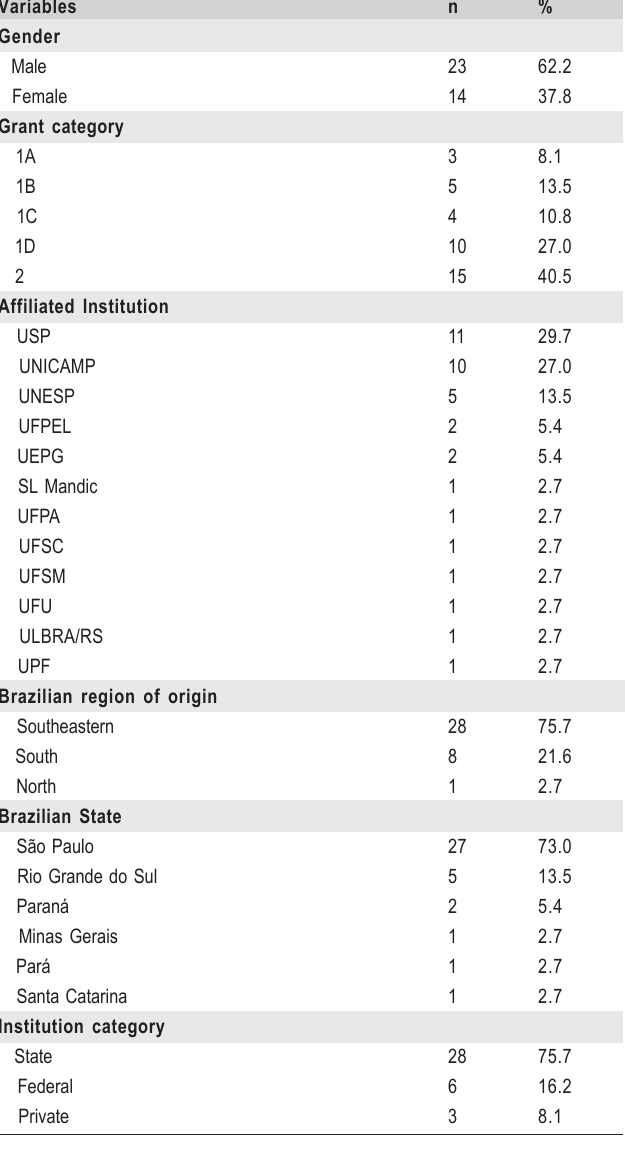
Table 1. Distribution of researchers according to gender,